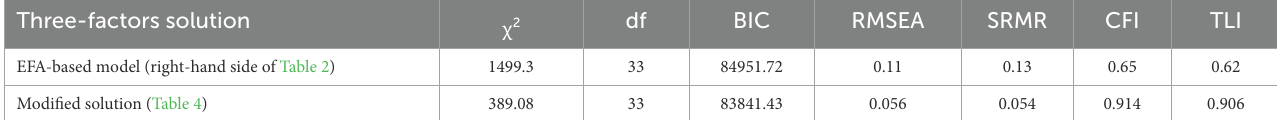
TABLE 3 Goodness-of-fit indices for three-factor solutions in Tables 2, 4. Three-factors